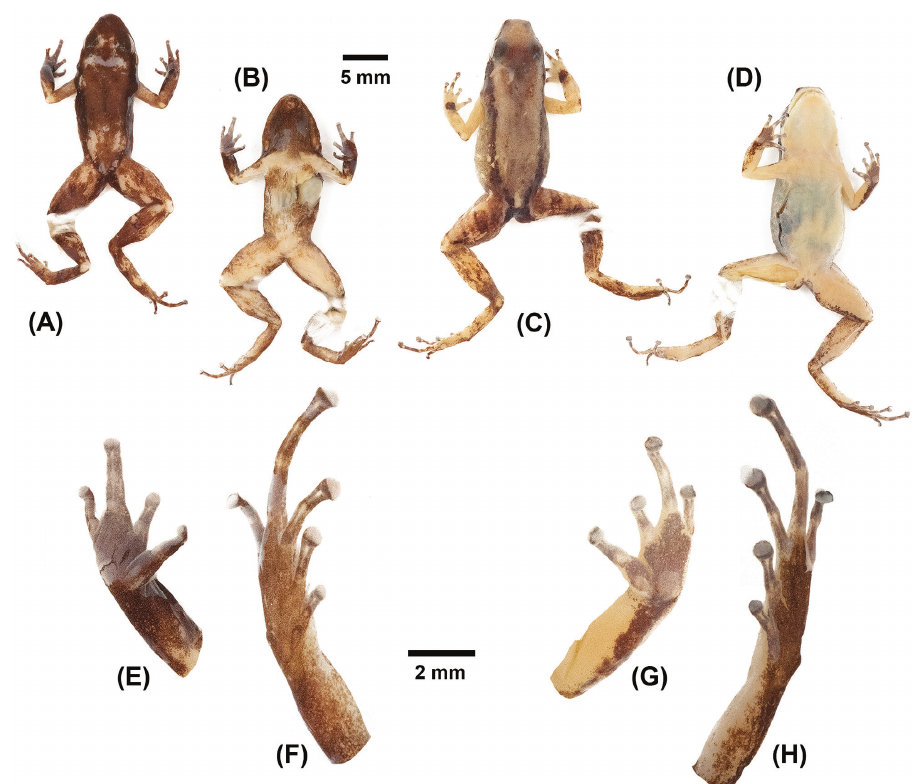
Figure 3. Anomaloglossus meansi sp. n. in preservative. A male holotype ROM 43896, dorsal view B male holotype ROM 43896, ventral view C female paratype ROM 43323, dorsal view D female paratype ROM 43323, ventral view E male holotype ROM 43896, ventral view of right hand F male holotype ROM 43896, ventral view of right foot G female paratype ROM 43323, ventral view of left hand H fe- male paratype ROM 43323, ventral view of left